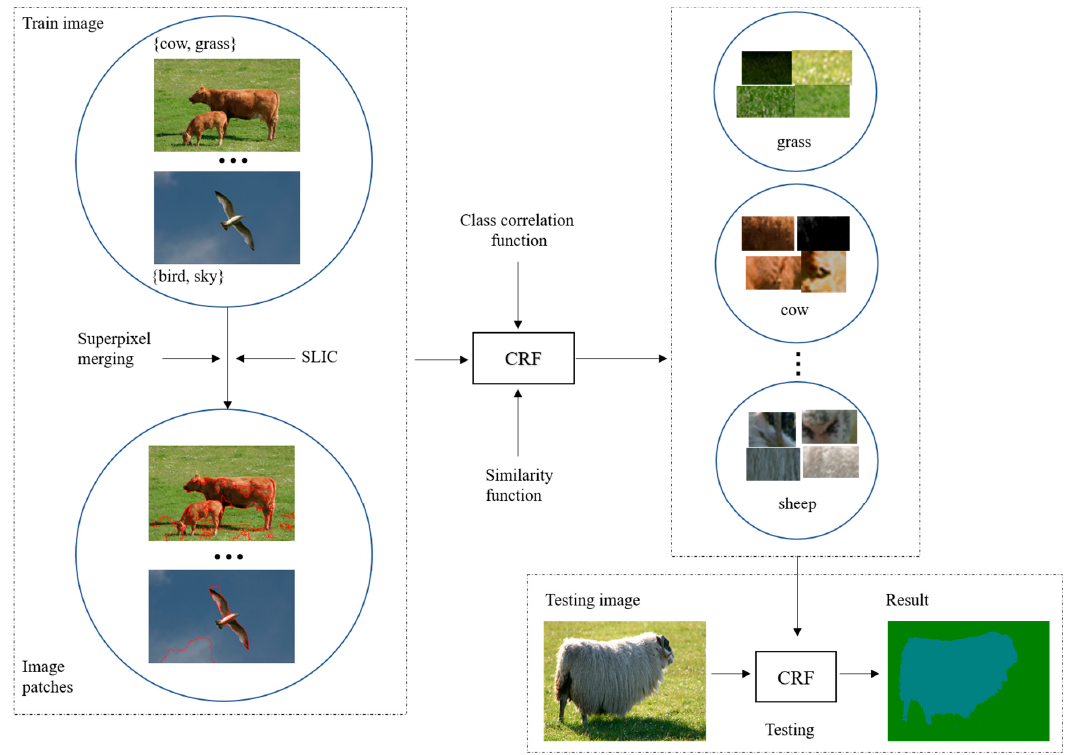
Figure 1. The flowchart of our framework.